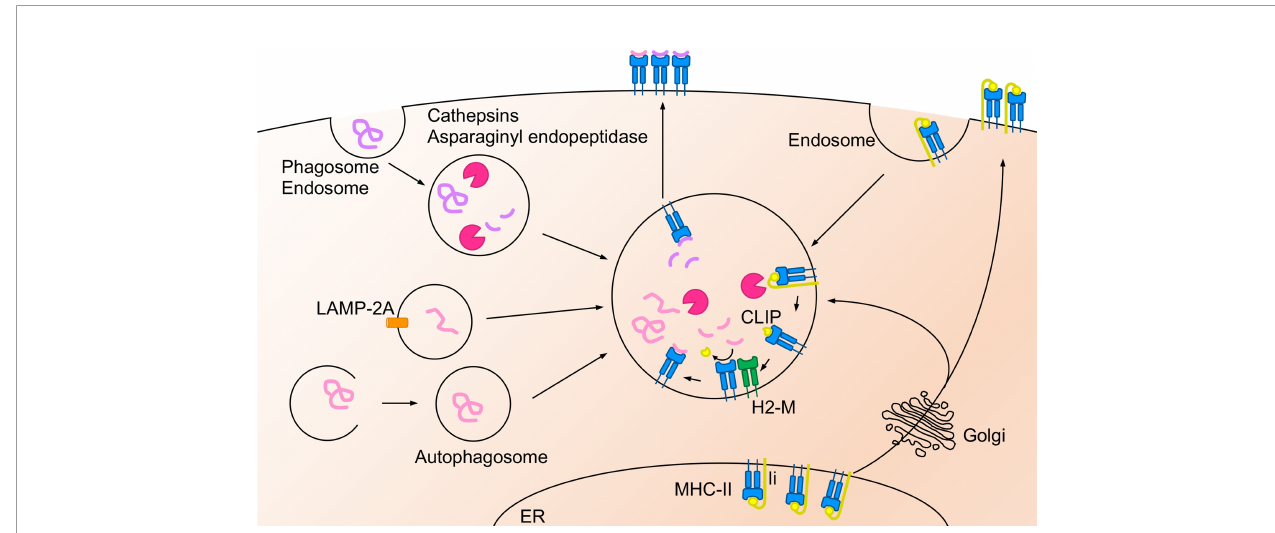
FIGURE 2 | Antigen cross-presentation on MHC-I molecule. Extracellular antigens are presented via “ vacuolar pathway ” or “ cytosolic pathway ” in the cross-presentation pathway. In the vacuolar pathway, endocytosed antigen peptides are degraded by cathepsin S and bind to MHC-I in the endosomal compartment. In the cytosolic pathway, endocytosed or phagocytosed extracellular antigens are translocated to the cytosol via Sec61 and degraded by proteasome. The degraded peptides are transported into the ER or the endosome via TAP and trimmed by ERAP (in the ER) or IRAP (in the endosomes). TAP form PLC with MHC-I, ERp57 and calreticulin. Afterward, the trimmed peptides bind to the MHC-I and transported to the cell surface. The MHC-I in the endosomes is recruited from the plasma membrane through Rab11a + recycle endosome, the ER, or the ERGIC. Antigen degradation regulated by the acidi fi cation in the endosome, the phagosome, and the lysosome by V-ATPase. On the other hand, NADPH oxidase NOX2 regulates phagosomal alkalization and is recruited to the phagosomes by Rab27a-dependent